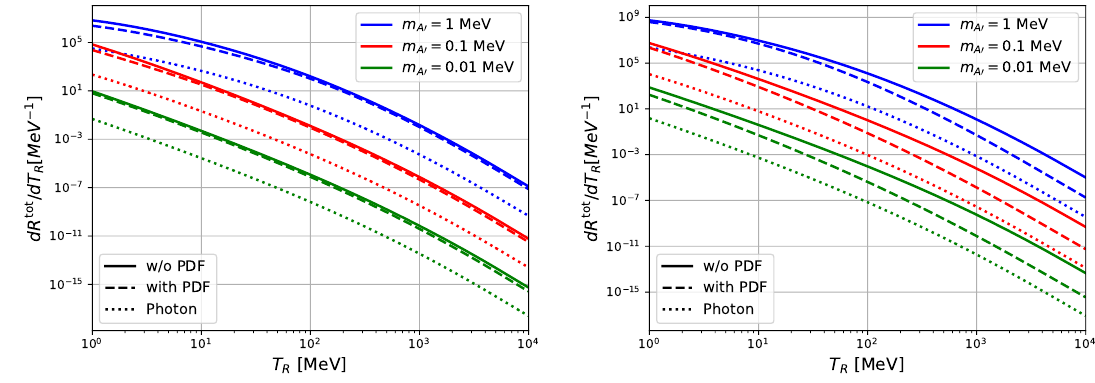
Figure 6 . The differential recoil rate (at Super-K with data taking of 2628.1 days) for recoiled electron without DM PDF effects (solid line), with DM PDF effects (dashed line) and for the outgoing photon (dotted line), where we have taken fixed dark photon mass as indicated in the legend, DM mass m χ = 0 . 01 MeV, signal efficiency ξ = 0 . 93 and the (cid:15) is chosen as the maximal value that satisfies the XENON1T and Super-K bounds. Left panel: DM coupling g 0 = 1 ; Right panel: DM coupling g 0 = 3